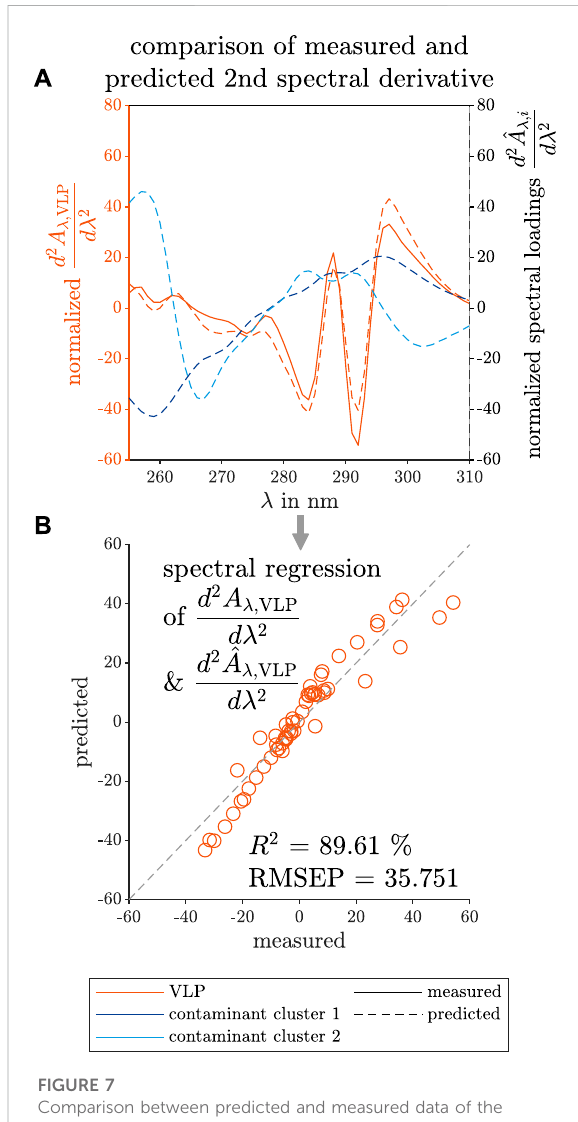
FIGURE 7 Comparison between predicted and measured data of the spectral loadings of the selective VLP precipitation screening. The measured reference data (left axis) and the predicted loadings (right axis) are illustrated with solid and dashed lines, respectively. The colors orange, dark blue, and light blue indicate the VLPs, and two contaminant clusters. The predictions of the ^ A λ , of the species i and the spectral second derivative spectra d 2 i d λ 2 second derivative measurements d 2 A λ , VLP of puri fi ed VLP solutions d λ 2 are mean-normalized and depicted over the wavelength λ in (A) . ^ A λ , The predicted spectral second derivative loadings of VLPs d 2 VLP d λ 2 and the reference d 2 A λ , VLP are used to plot the predicted over the d λ 2 measured data in (B) . The gray dashed line visualizes the ideal fi t of the predicted to the measured data. The measured and the predicted spectra are used to calculate the coef fi cient of determination R 2 values to quantify the validity of the constructed